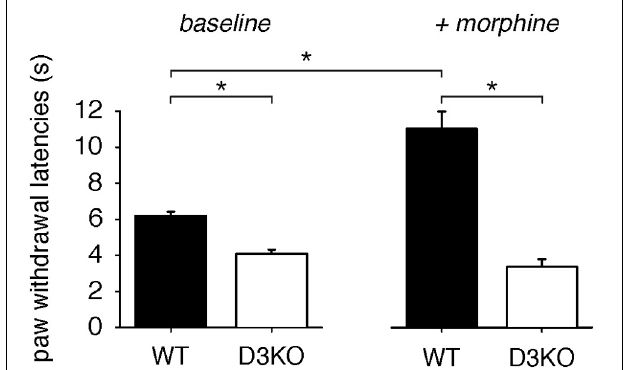
FIGURE 1 | Thermal pain withdrawal latencies at baseline and after a single i.p. application of 2mg/kg morphine. Left panel: Baseline data for WT ( n = 8) and D3KO ( n = 10). Under control conditions, D3KO displayed a significantly lower time to withdrawal than WT. Right panel: D3KO ( n = 5) continued to maintain a lower withdrawal time than WT ( n = 4), but morphine significantly increased latencies in WT but not D3KO. ∗ indicates p < 0 .